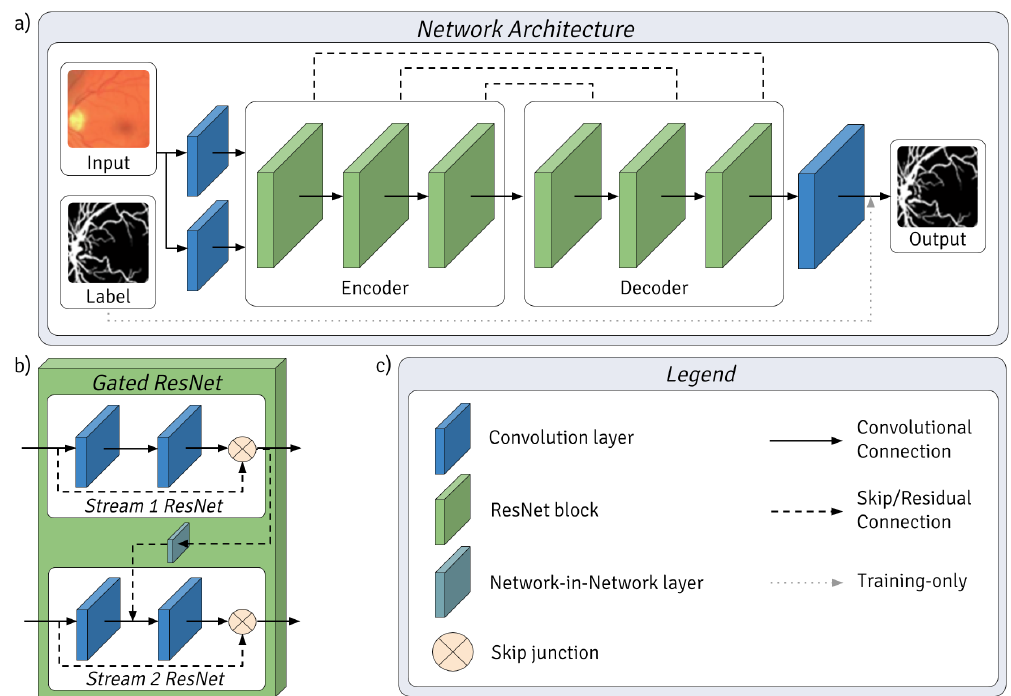
Figure 1. ( a ) The overall network architecture is shown, whereby processed image patches are passed through two convolution layers with different filters to create parallel input streams for the encoder. Convolutional downsampling occurred between each ResNet block in the encoder and deconvolutional upsampling in the decoder. Each ResNet block consisted of 4 Gated ResNets, forming encoder–decoder pairs. The output was a vessel mask of equal size to the input. The label was used to train the network. ( b ) Gated ResNet architecture. ( c ) Legend for the layers, blocks and